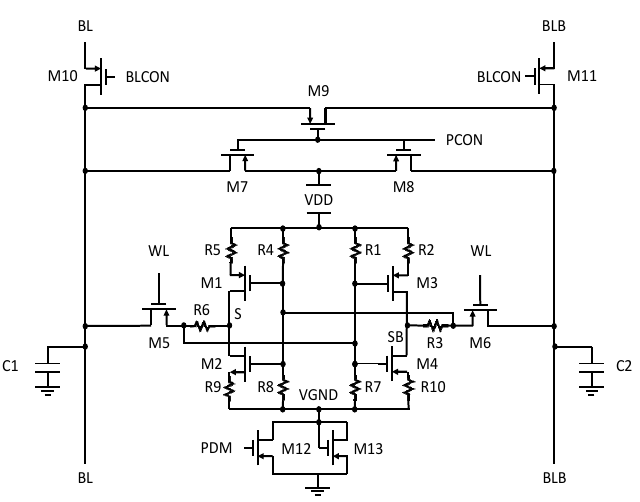
Figure 4. 6T-SRAM with pre-charge circuit.